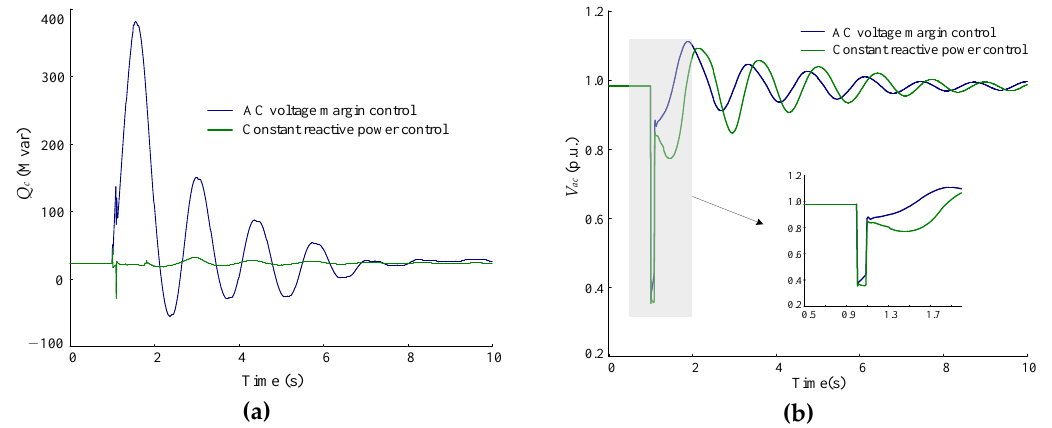
Figure 5. Transient responses of AC/DC system under different reactive power control modes. ( a ) Reactive power output of VSC-HVDC; ( b ) bus voltage at AC-side of the converter.